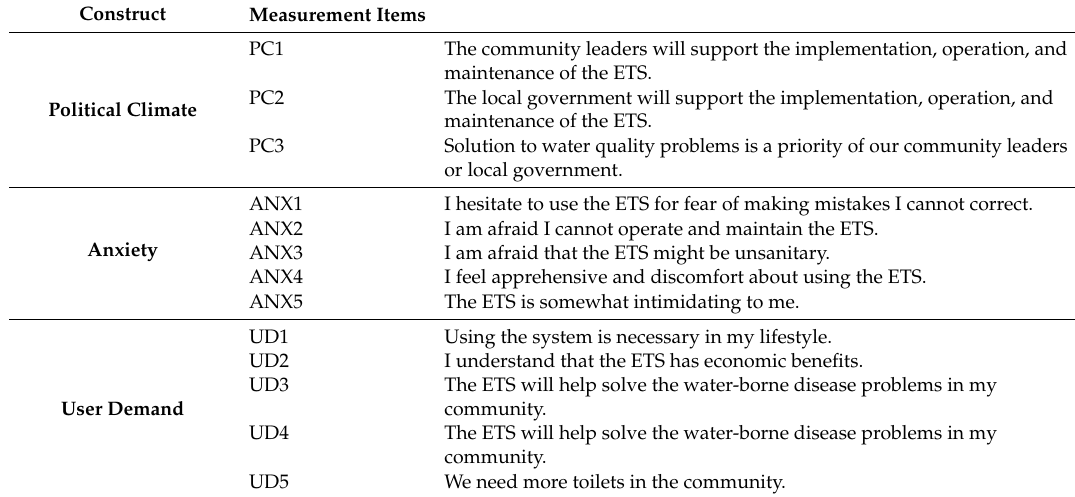
Table A3. C-TAM-TPB Questionnaire for RWHS and